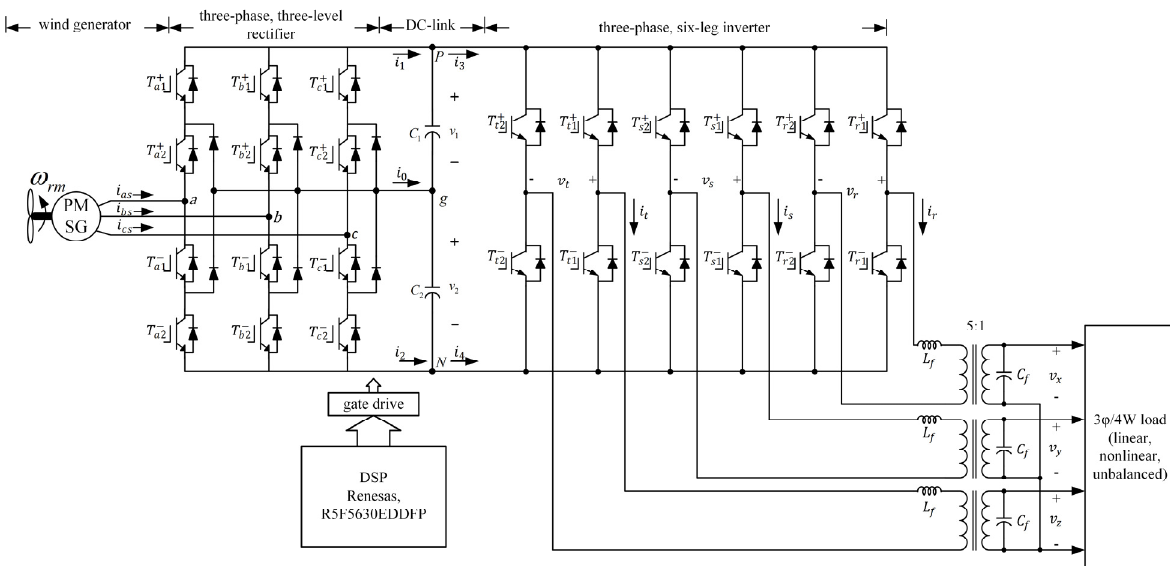
Figure 1. Block diagram of the proposed